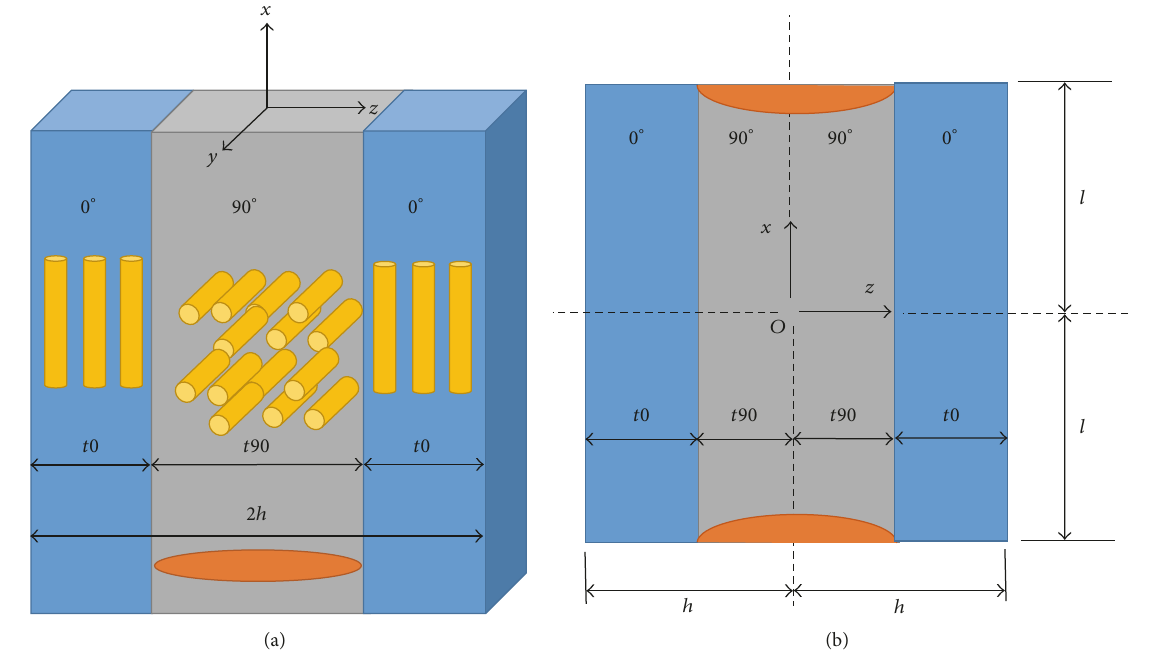
Figure 2: (a) Unit cell used to derive the equations of the McCartney model. (b) Coordinates for boundary conditions shown in Table 1. Adapted from